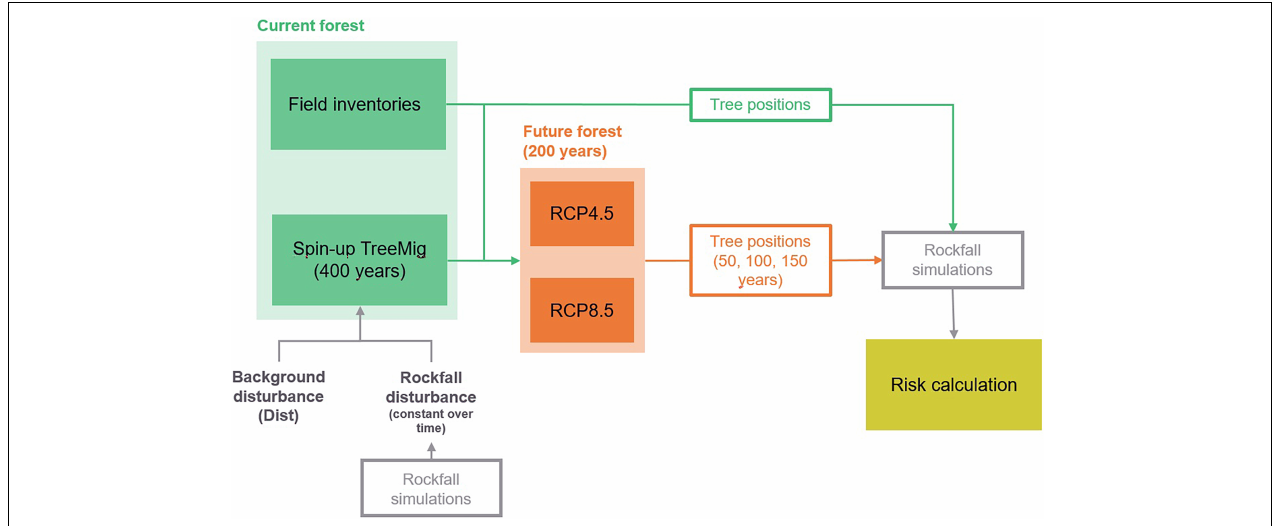
FIGURE 3 | Schematic overview of the methodological approach of this study.